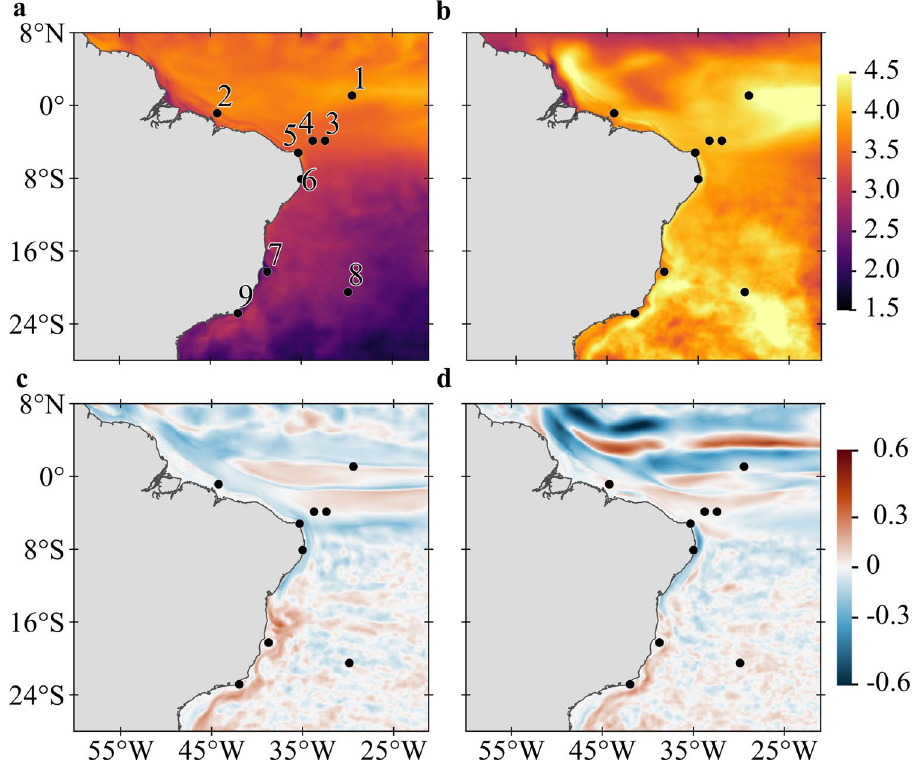
Figure 1. Differences between future (RCP8.5, 2092–2099) and historic (1997–2004) simulations for SST and current magnitude averaged for the ocean upper 100 m layer. ( a ) Summer (JFM) and ( b ) Winter (JAS) for SST (°C); larger differences of temperature between simulations are shown in yellow tones and smaller differences in purple tones. ( c ) Summer (JFM) and ( d ) Winter (JAS) for current magnitude (m s −1 ); red tones indicate current strengthening and blue tones indicate current weakening. Black dots represent MPA locations: (1) São Pedro e São Paulo Archipelago (SPSP); (2) Manuel Luís (ML); (3) Fernando de Noronha Archipelago (FN); (4) Atol das Rocas (AR); (5) Recifes de Corais (RC); (6) Costa dos Corais (CC); (7) Abrolhos (AB); (8) Martim Vaz e Trindade Archipelago (TR); and (9) Arraial do Cabo and Cabo Frio region (CF). Created with Matlab R2019a (www. mathw orks. com) and QGIS-3.4 (https:// www. qgis.